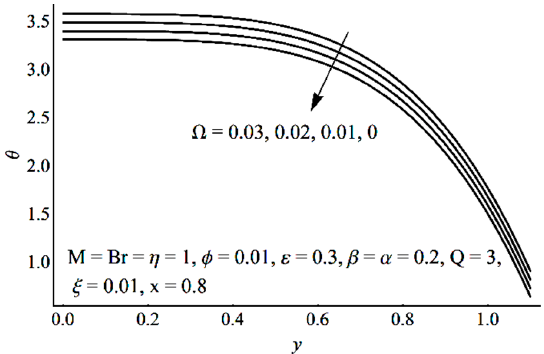
Figure 14. The temperature profile against various values of temperature jump Ω .